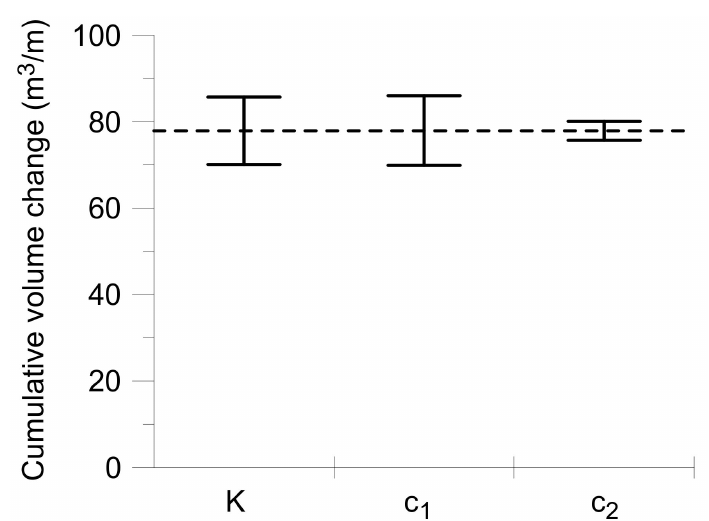
Figure 18. The cumulative volume changes at the end of the investigation period simulated using the values of K , c 1 , and c 2 that were increased and decreased by 10%. The broken line shows the volume simulated using the best-fit parameter values.